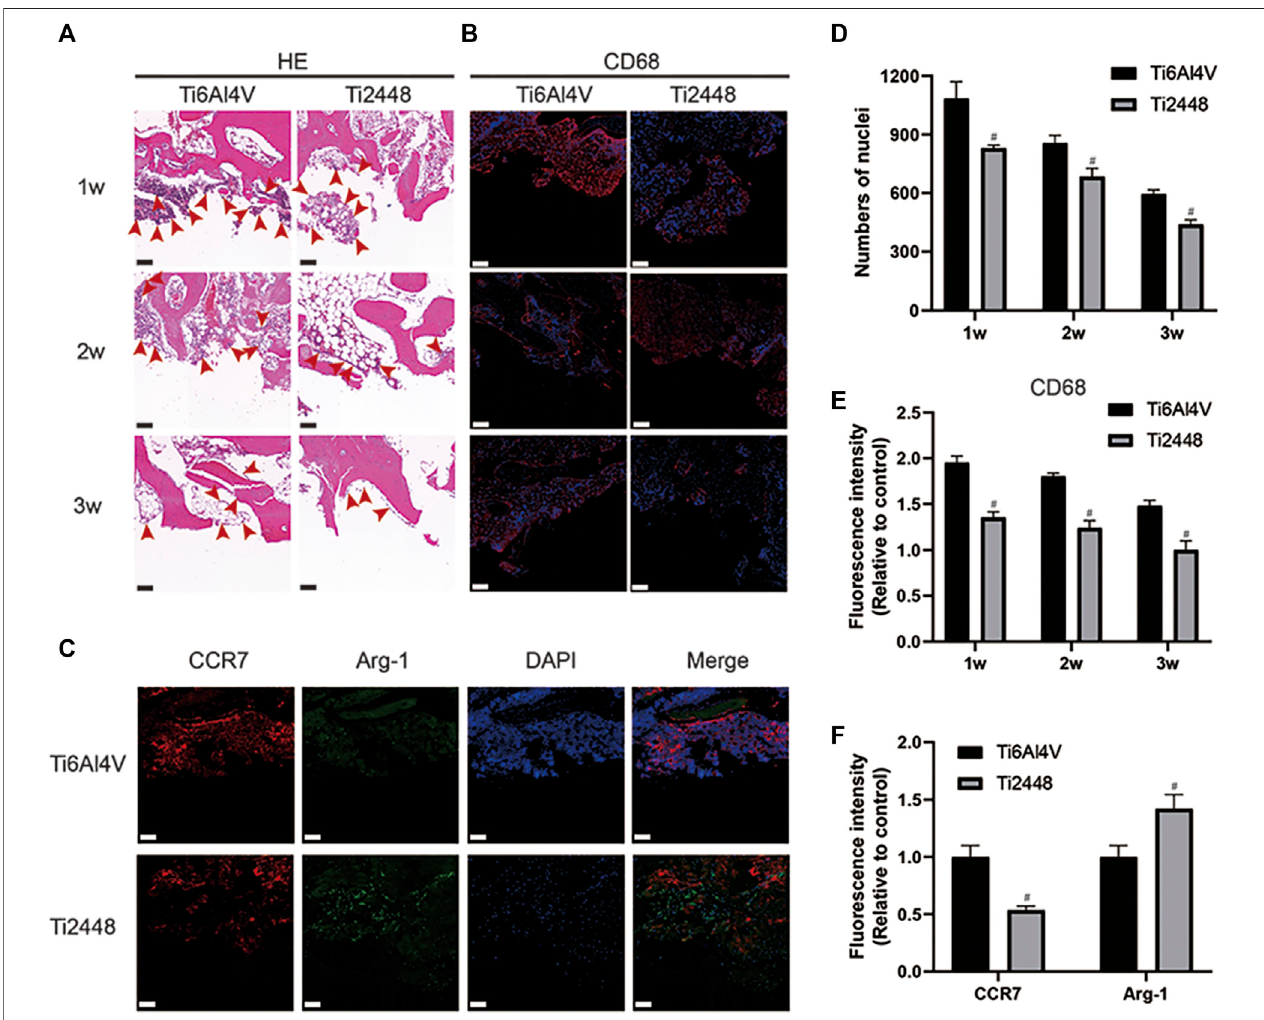
FIGURE 5 | In fl ammatoryresponse toscaffolds evaluatedand analysedinbonetissue. HEstaining ofbonetissue at 1,2,and 3 weeks after implantation. Scale bar (cid:2) 100 µm (A) .Evaluationofin fl ammationbyimmuno fl uorescencestainingforthemacrophagemarkerCD68inbone.Scalebar (cid:2) 200 µm (B) .Immuno fl uorescencestainingfor CCR7 (marker for M1macrophages)and Arg-1 (markerfor M2 macrophages) intheboneat2 weeks.Scalebar (cid:2) 100 µm (C) . Quantitativeanalysisofthe numberofnuclei aroundthescaffolds (D) .Quantitativeanalysisofthe fl uorescenceintensityofCD68aroundthescaffolds (E) .Quantitativeanalysisofthe fl uorescenceintensityofCCR7 and Arg-1 around the scaffolds (F) . Note: # p ＜ 0.05 compared to